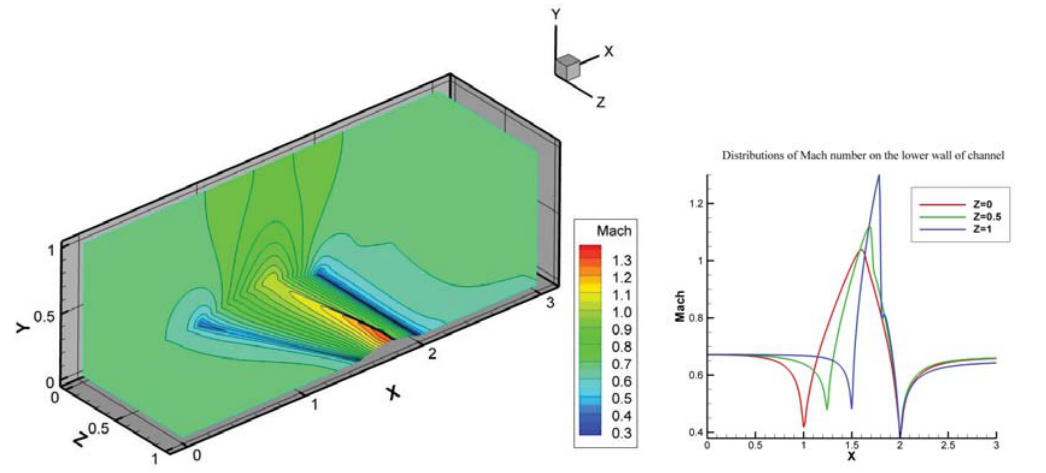
Figure 9: Inviscid compressible flow around the S WEPT W ING in the channel: Mach number iso- lines at M 1 = 0 . 675 (left) and distributions of Mach number on the lower wall in the slides (right) – MUSCL scheme by J. Holman [3], IBC A , a structured non-orthogonal grid with 180 × 35 × 35 cells.